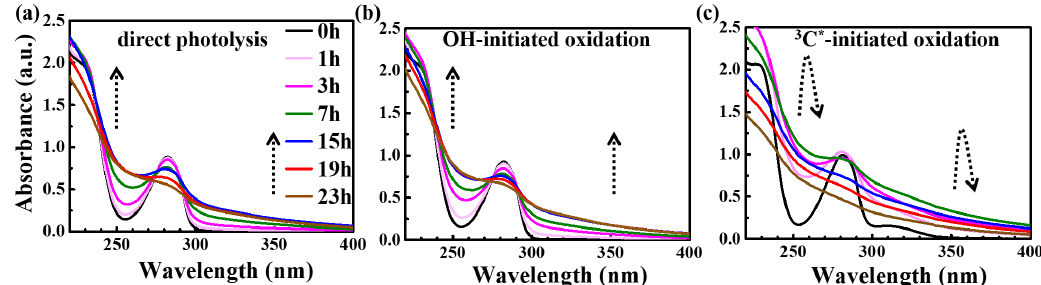
Figure 5. UV-vis light absorption spectra of reacted solutions at different reaction times under (a) direct photolysis, (b) OH-initiated oxida- tion, and (c) 3 C ∗ -initiated